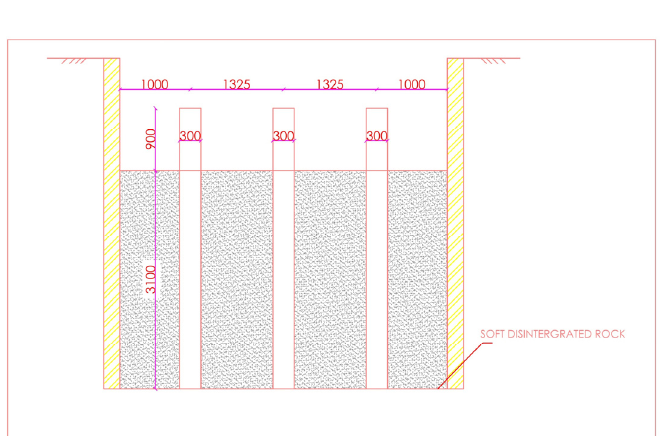
Figure 3. Schematic view of the pile setup.